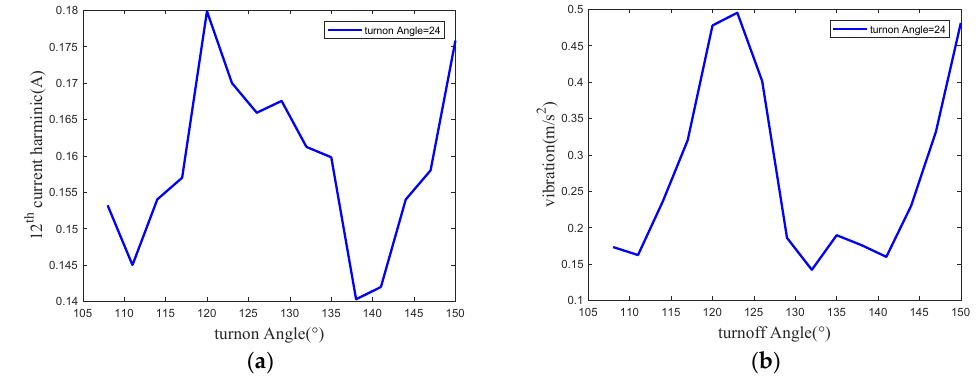
Figure 9. The 12th current harmonic and the 2nd vibration value under different turn-on angles (15– 48°) ( a ) Variation curve of 12th order current harmonic with turn-on angle ( b ) Variation curve of second-order vibration amplitude with turn-on angle.